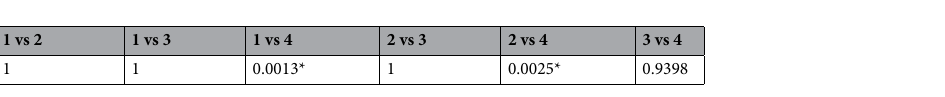
Table 3. Bonferroni correction p-value for multiple comparison of pregnancy rates (%). A p-value < 0.05 was considered statistically